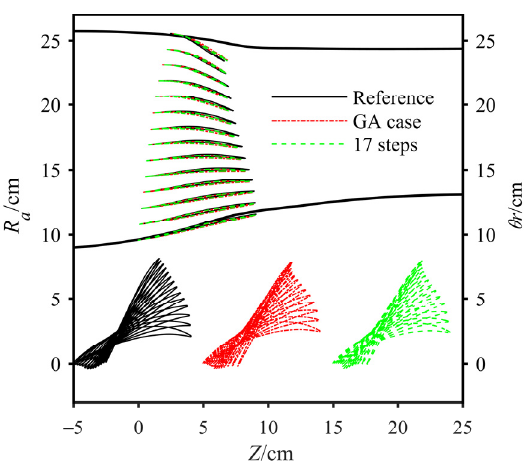
Figure 16. Rotors in Z R - and Z θ r - surface.